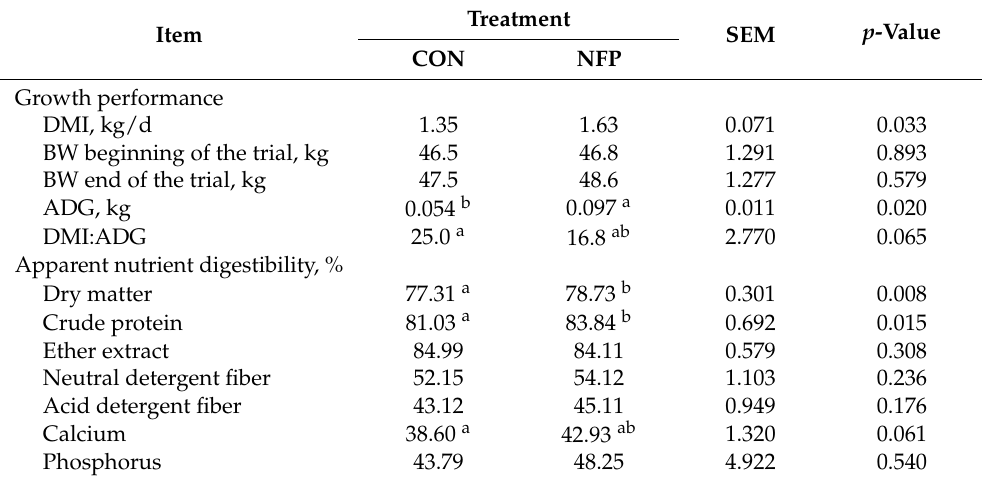
Table 6. The effect of NFP on growth performance and apparent nutrient digestibility in cashmere